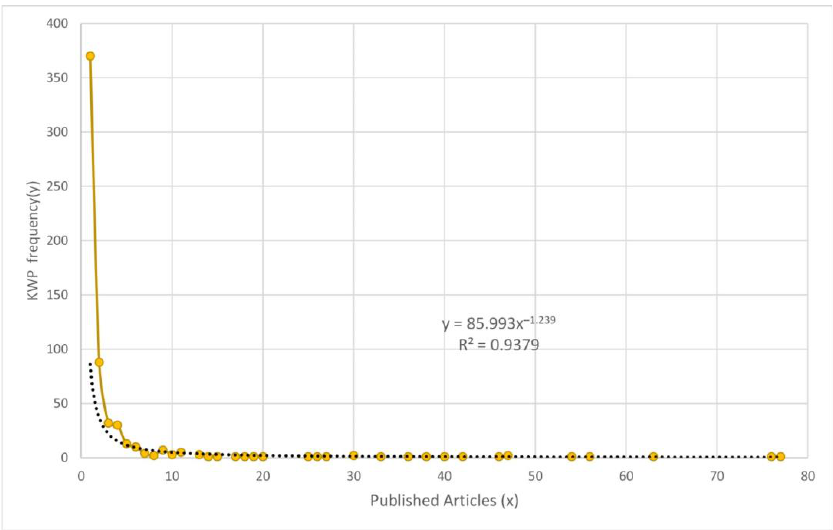
Figure 7. Relationship between scientific production level and KWP frequency.